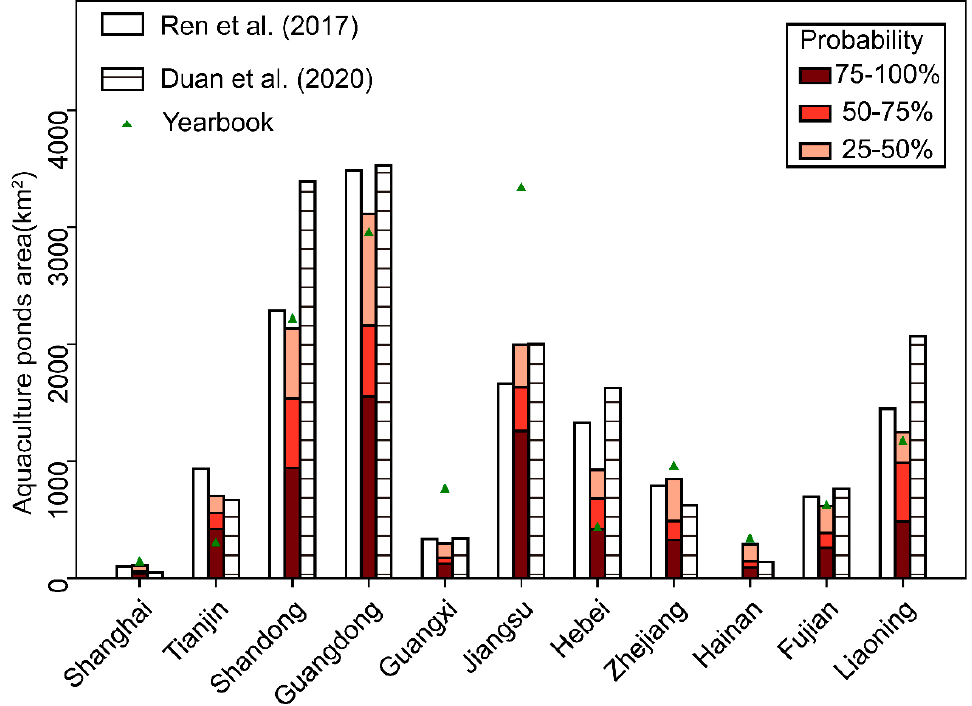
Figure 8. The comparison of the different extraction results of various coastal provinces in China shows that our results are in good agreement with other studies [18,27].